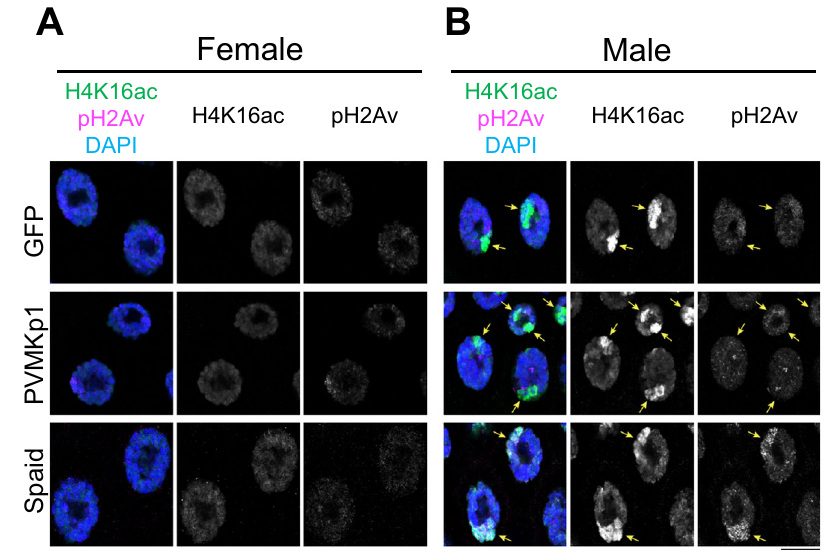
Fig.4|Expressionandtheeffectoftwomale-killinggenes. Female( A )andmale ( B ) larval salivary glands of D. melanogaster expressing GFP (female, n =9; male, n =10),PVMKp1(ORF4)(female, n =12;male, n =9), and Spaid(female, n =9;male, n =9).Staining for acetylated histone H4lysine 16 (H4K16ac;green) indicatesmale